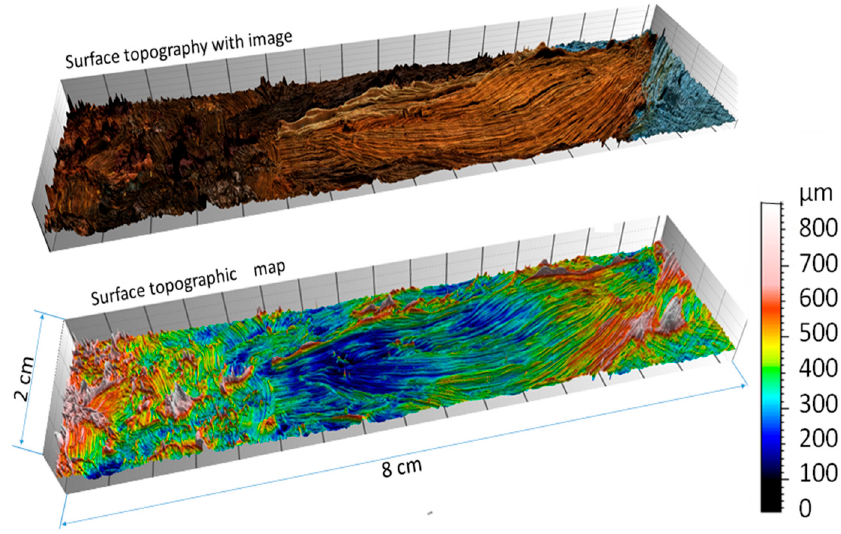
Figure 8. Digital model of surface topography using focus variation microscopy.